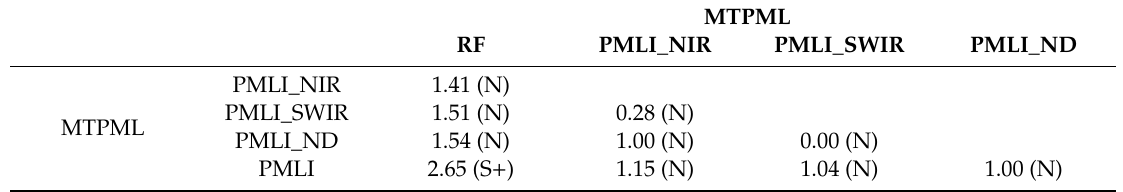
Table 5. McNemar’s test result in GY.